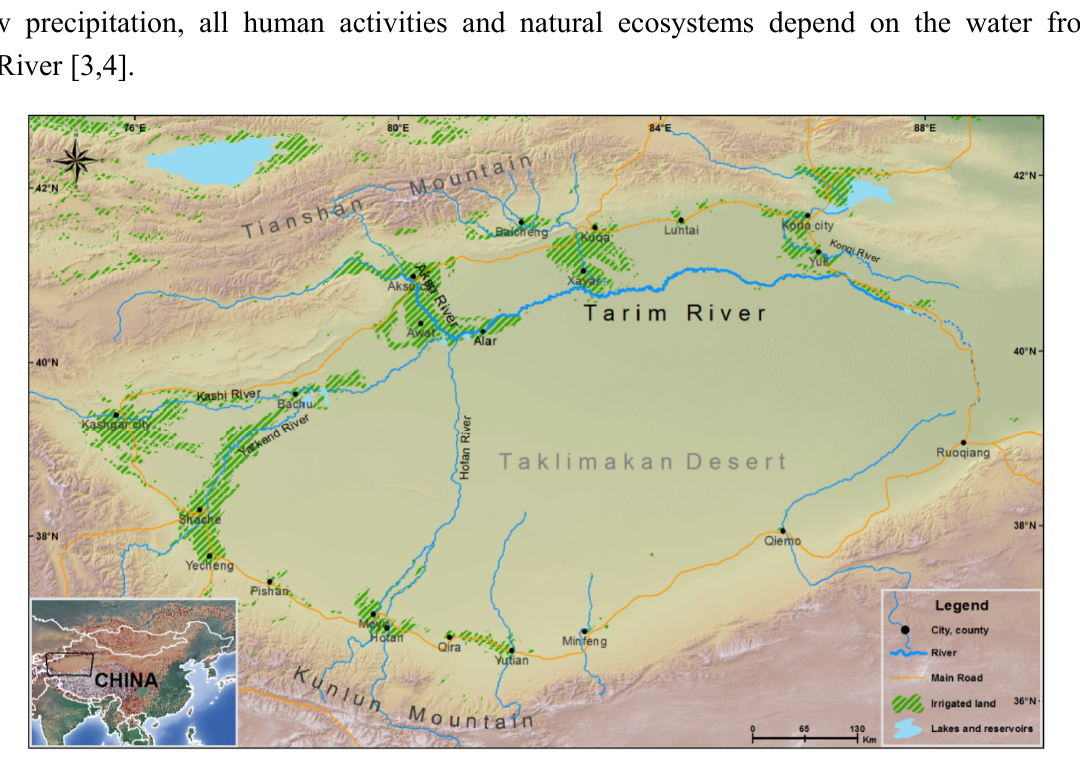
Figure 1. Map of the study